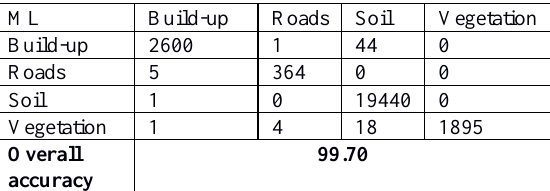
Table 3. Accuracy of predicted materials by ML classification technique.